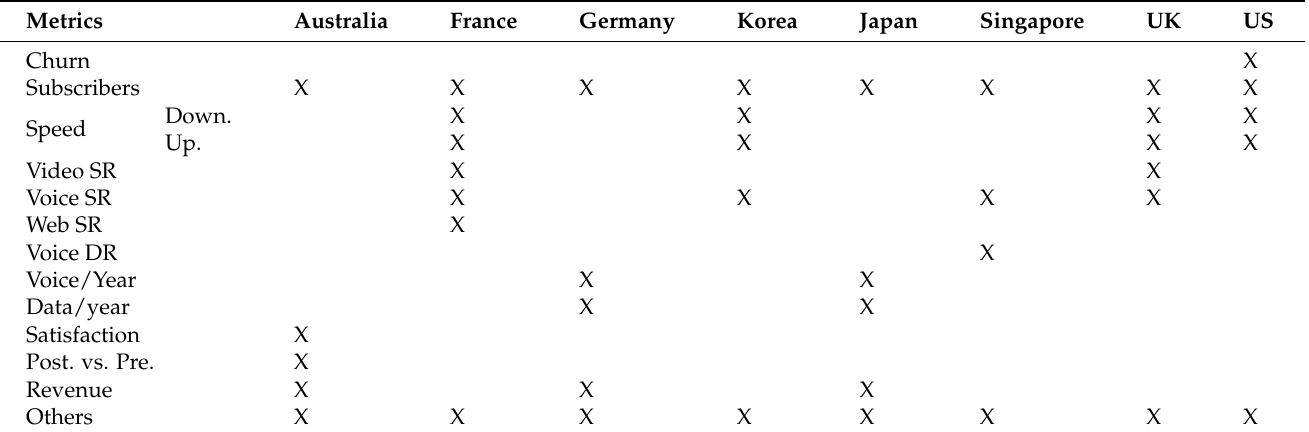
Table 6. Other types of metrics to evaluate mobile